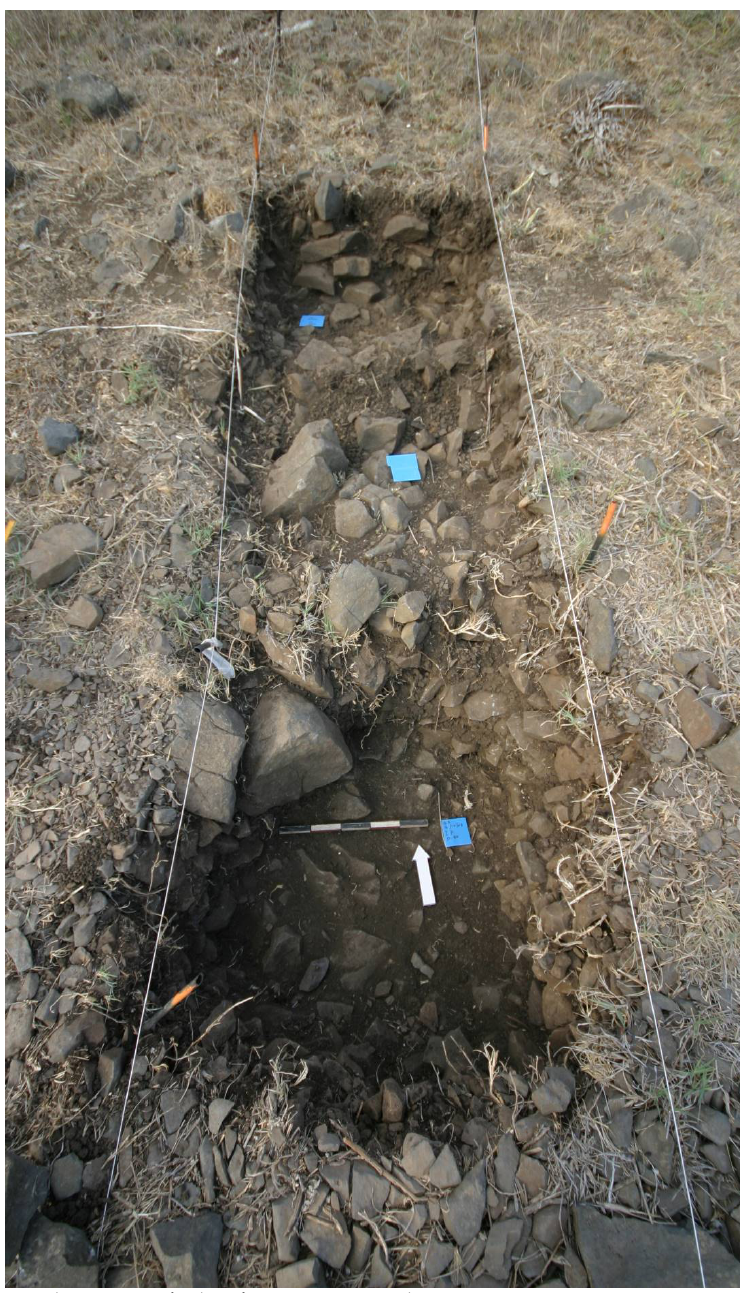
Figure 4. Squares. I7-I9 in Locus 1 during the 2007